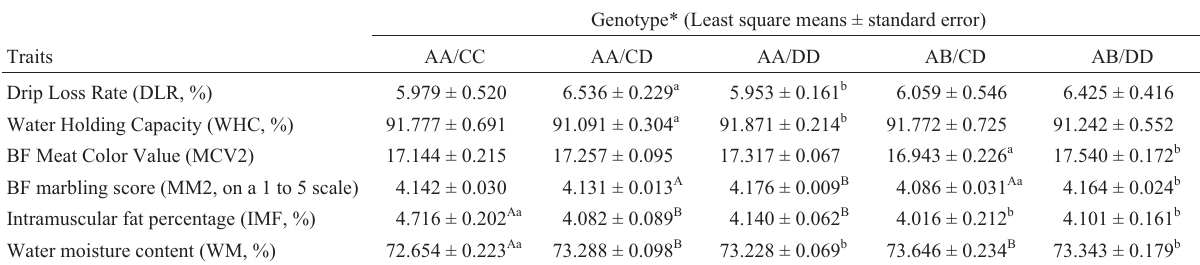
Table 2 - Association of haplotypes in the MYF 5 gene with the phenotype value of partial meat quality traits in population 2 (n = 172), consisting of 50 Meishan, 78 Yorkshire x Meishan and 44 Meishan x Yorkshire pigs. Within-trait ( i.e. within the same row) significant differences between the genotype classes are indicated by superscripts, lower case at p < 0.05 and upper case at p < 0.01. Genotype* (Least square means ± standard